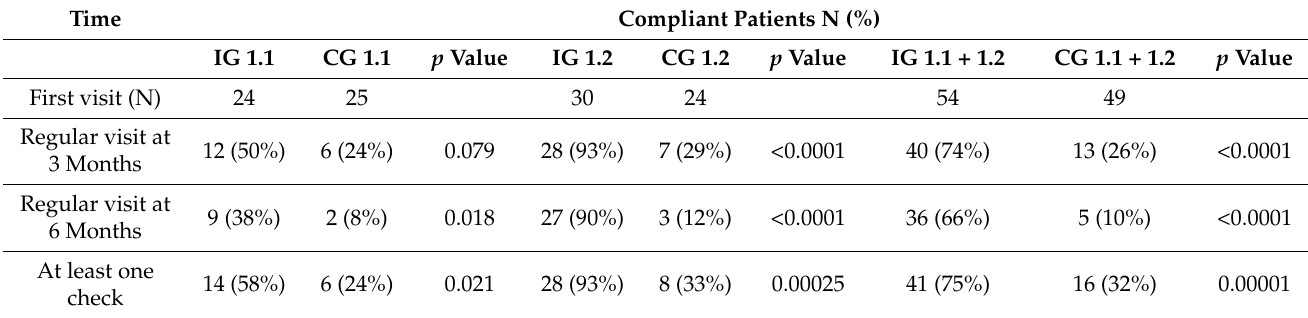
Table 2. Adherence to